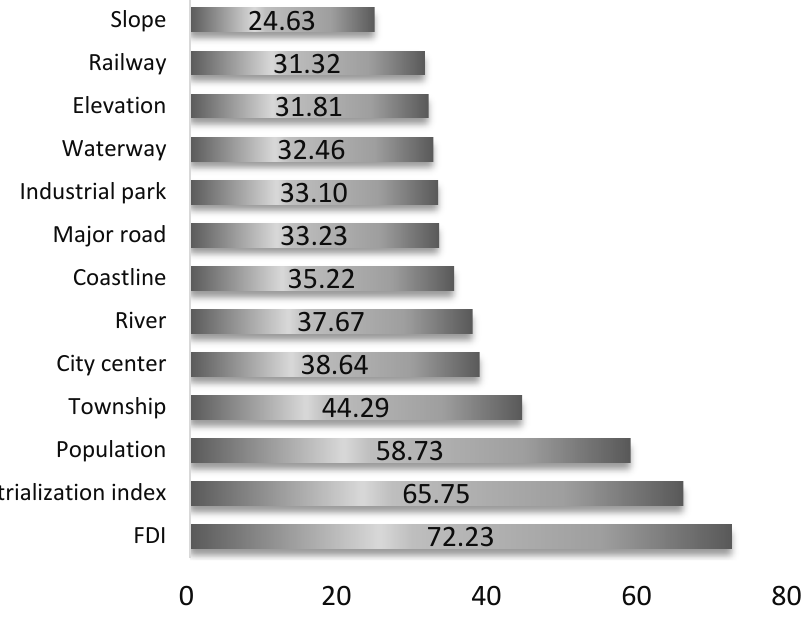
Figure 7. The importance of driving factors from 2000 to 2020.